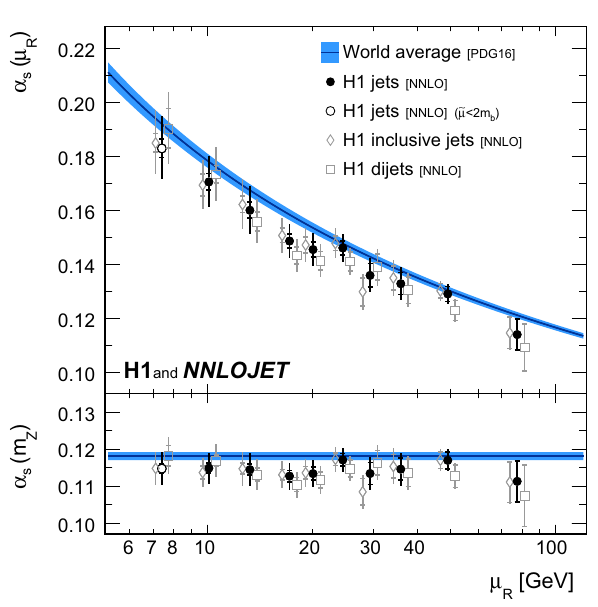
Fig. 13 Results on α s ( m Z ) and α s (μ R ) for fits to data points arranged in groups of similar μ R . The circles show results from inclusive jet and dijet data taken together (‘H1 jets’), the open diamonds results from inclusive jet cross sections alone and the open boxes results from dijet cross sections alone. For these fits, the data sets are not constrained by the requirement ˜ μ > 2 m b . The fitted values of α s ( m Z ) (lower panel) are translated to α s (μ R ) (upper panel), using the solution of the QCD renormalisation group equation. The data points from fits to inclusive jets (dijets) are displaced to the left (right) for better visibility. In the upper panel a displacement is also applied along the vertical direction, to account for the running of α s (μ R ) . The inner error bars denote the experimental uncertainties alone, and the outer error bars indicate the total uncertainties ( m ) is fixed while it is a free parameter in NNPDF3.1, α PDF Z s the H1PDF2017 [NNLO] fit. Within uncertainties, the singlet distribution obtained for H1PDF2017 [NNLO] is in fair